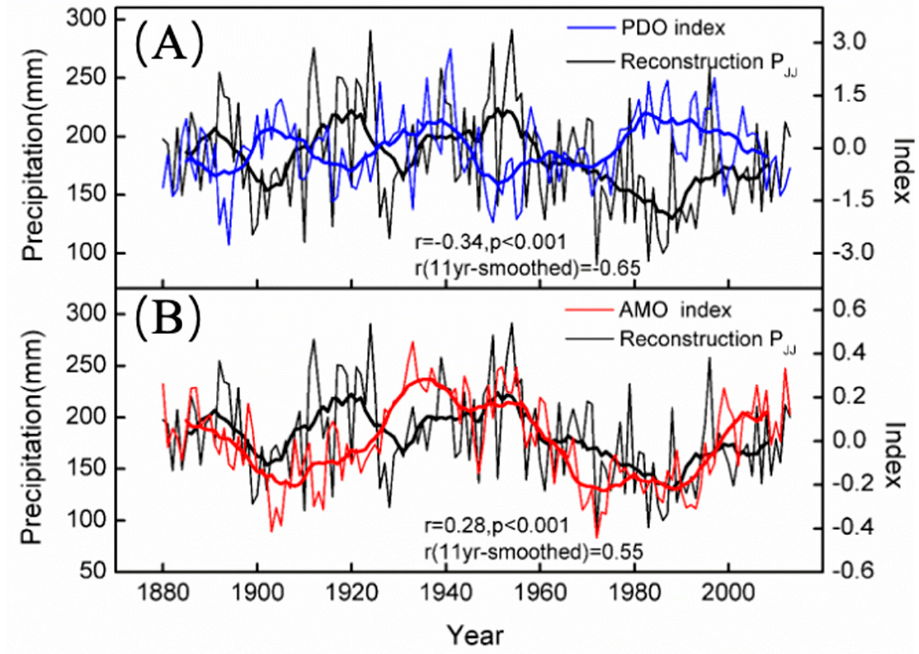
Figure 14. Comparisons of the reconstruction precipitation with ( A ) the PDO index ( B ) the AMO AMO index.